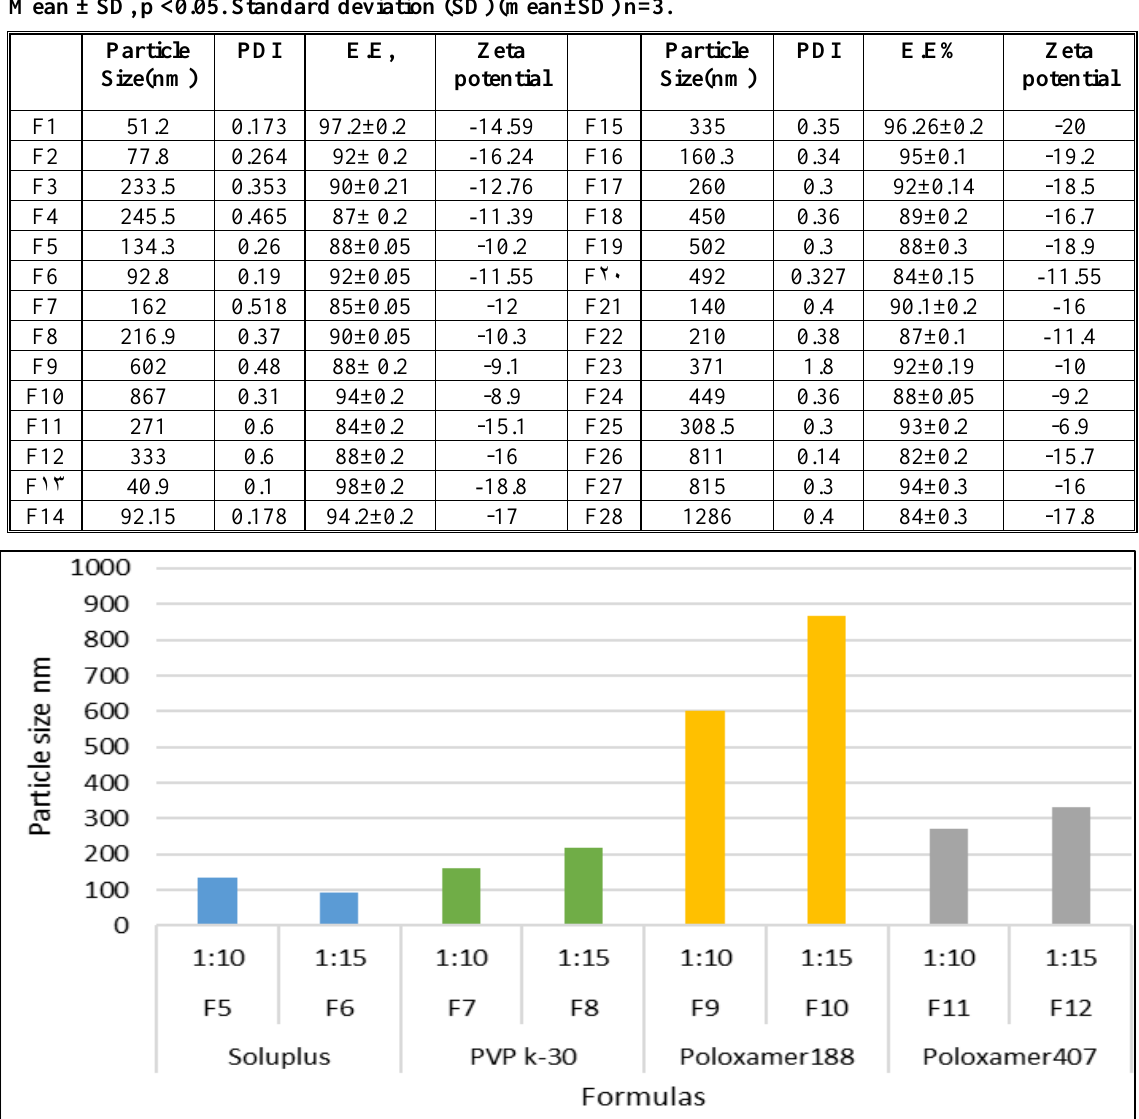
Table 2. Particle size, polydispersity index, and E.E. of formulas from 28 formula data are expressed as